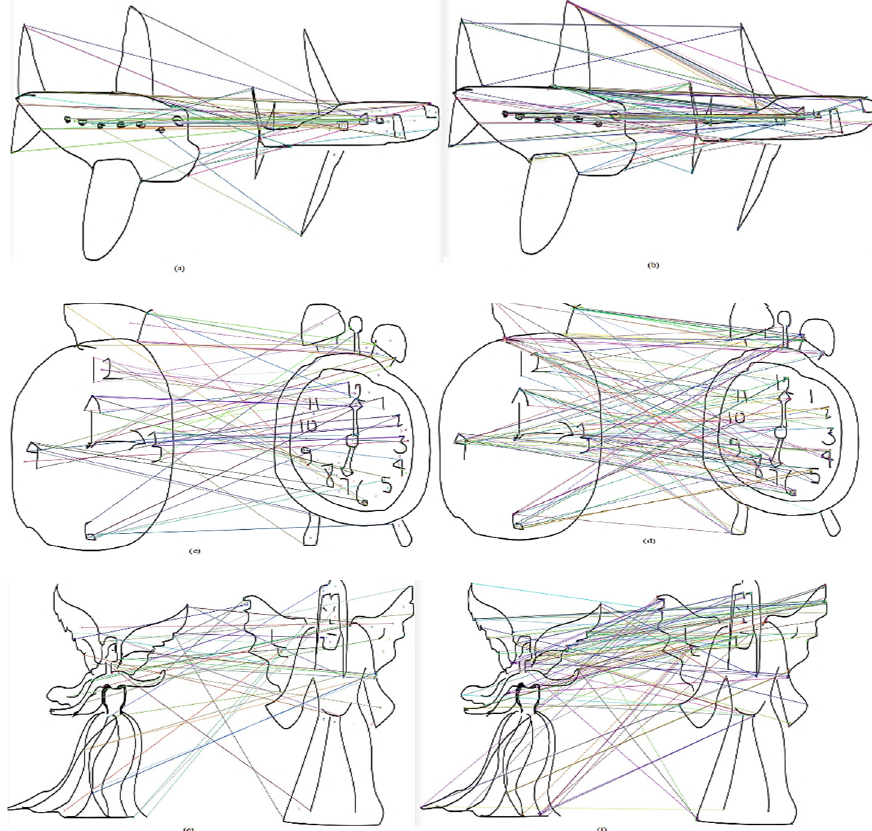
Figure 19. Matched points of ( a ) 1st pair for SIFT, ( b ) 1st pair for ORB, ( c ) 2nd pair for SIFT, ( d ) 2nd pair for ORB, ( e ) 3rd pair for SIFT, and ( f ) 3rd pair for ORB.